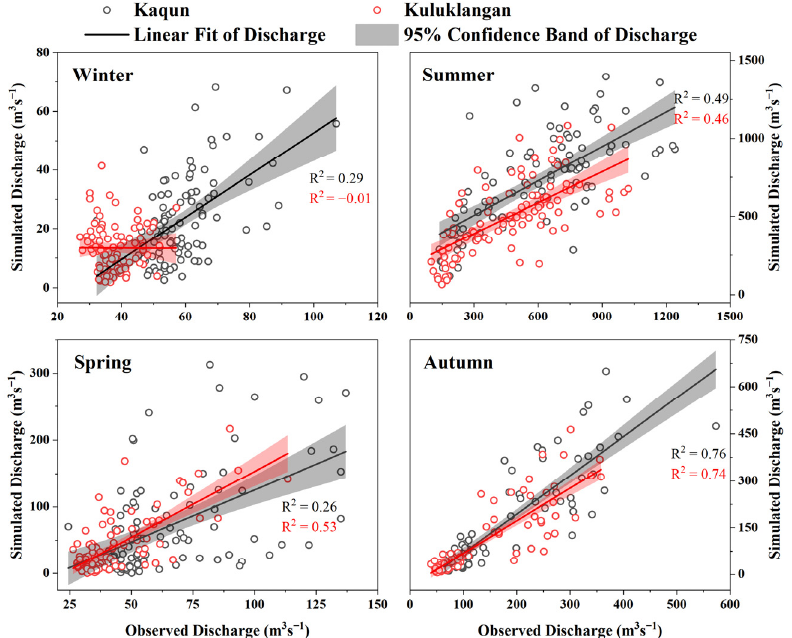
Figure 9. Model performance at seasonal statistics of the two hydrological stations from 1984 to 2015.